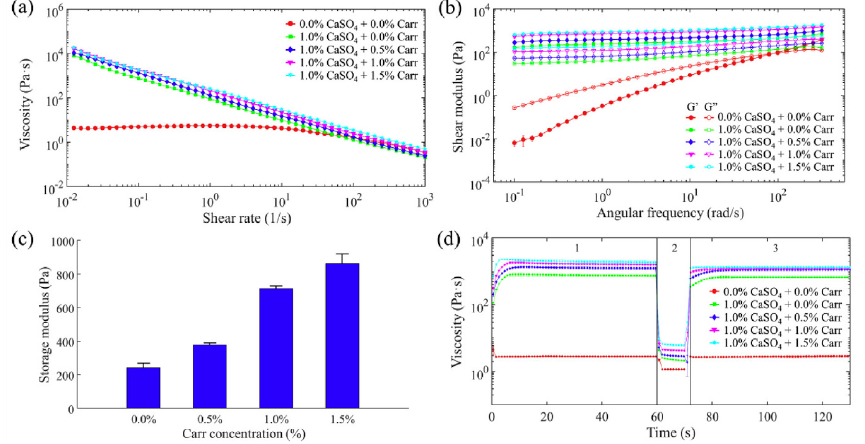
Figure 12. Rheological properties of a carrageenan-based bio-ink: ( a ) viscosity of the Alg-Carr-CaSO 4 as a function of shear rate (0.01–1000 s − 1 ); ( b ) shear modulus of the Alg-Carr-CaSO 4 composite as a function of angular frequency; ( c ) increasing storage modulus as the carrageenan concentration increases; ( d ) the variation of viscosity at various hydrogel compositions (reprinted from Kim et al., 2019 [377] , with the permission of Elsevier Ltd., published under license. Copyright © 2022 Elsevier Ltd.).